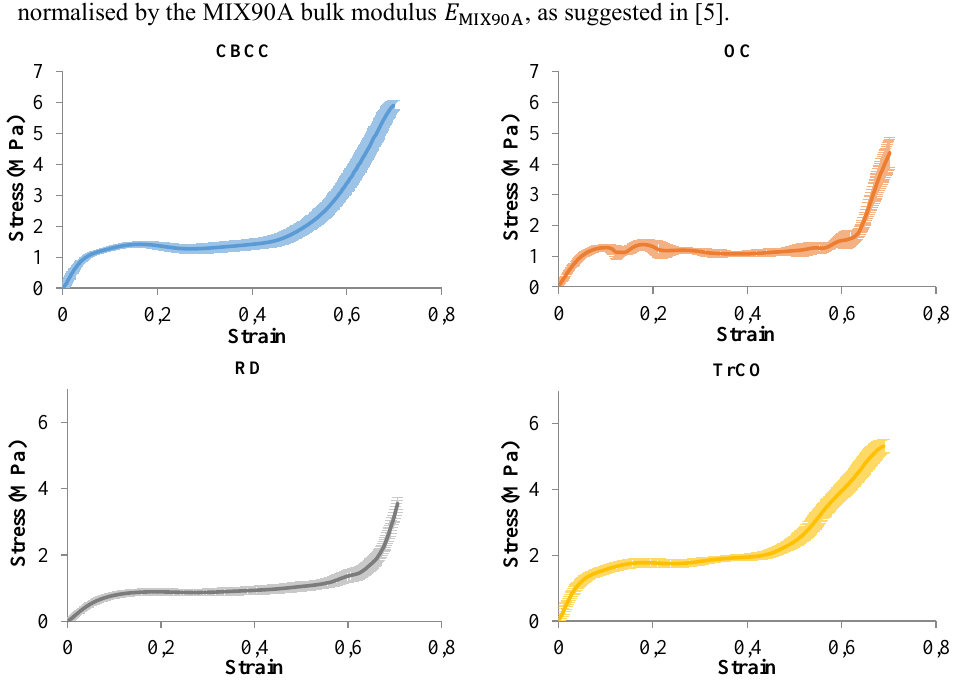
Fig. 4. Experimental results: averaged mechanical responses and their standard deviation